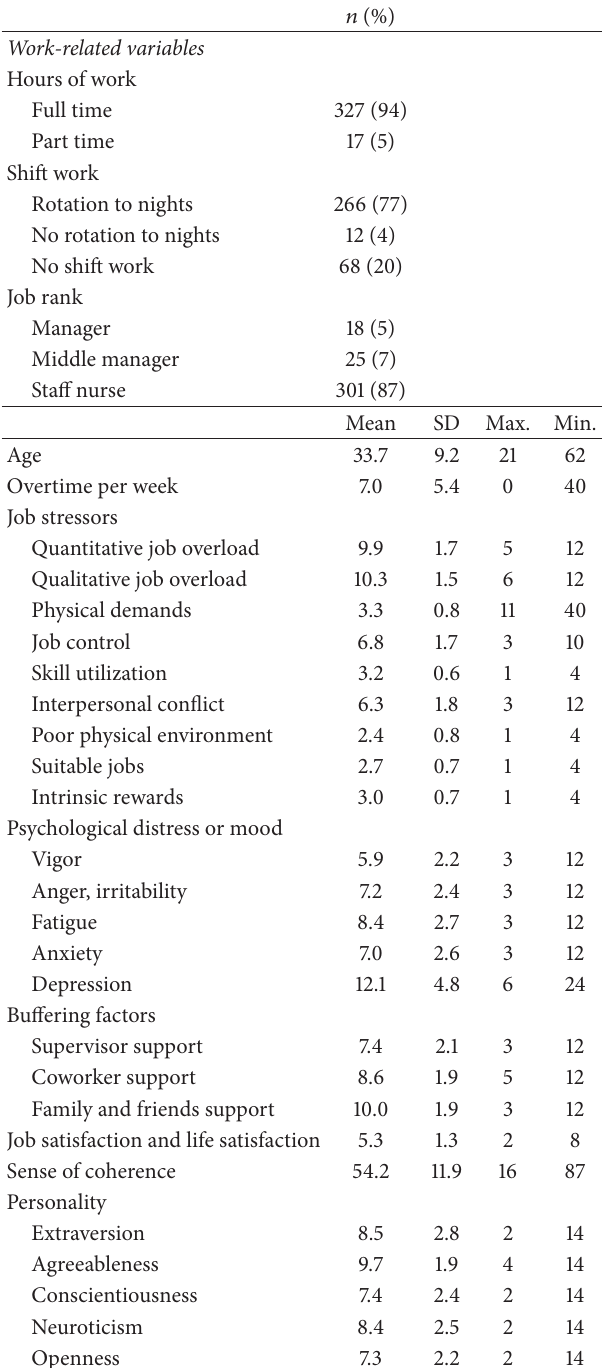
Table 1: Characteristics of the subjects (total 𝑁 = 347